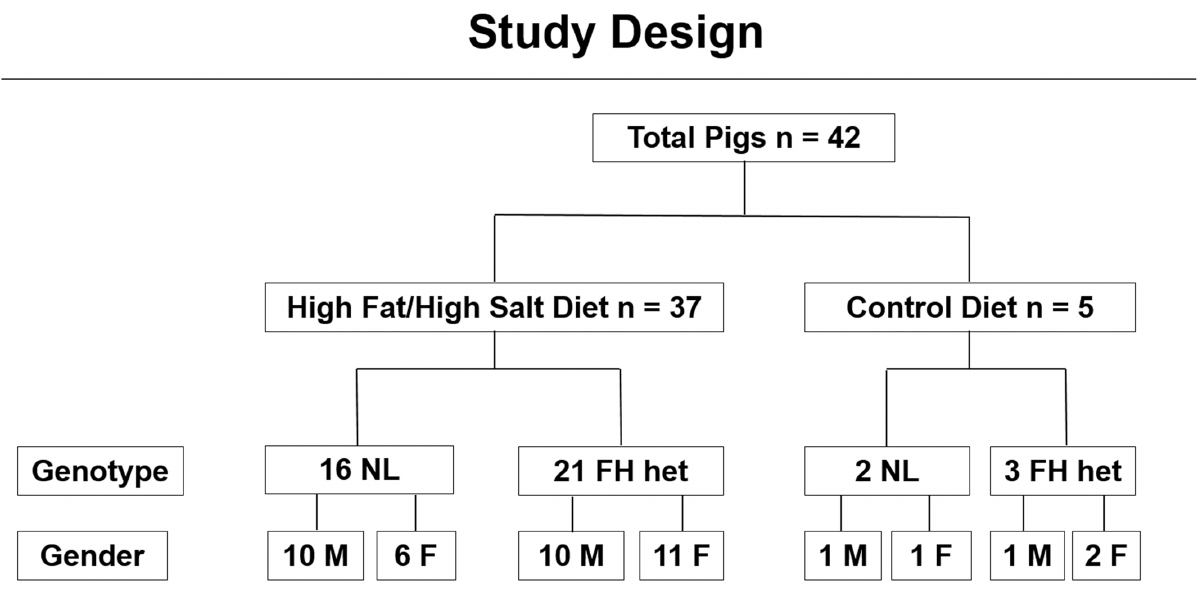
Fig 1. Study Design. The 42 pigs entered into this study are listed according to the diet they were fed, genotype (NL = normal, FH het = FH heterozygous) and gender.